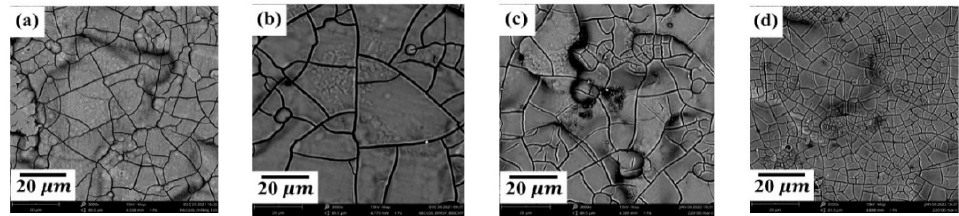
Figure 5. The 60 s chromium conversion treatment, 3000 diameter SEM surface images of Zn–Ni flakes at different NaF concentrations: ( a ) NaF 0%, ( b ) NaF 50%, ( c ) NaF 100%, and ( d ) NaF 150%.